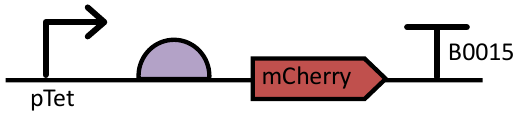
Figure 26: Examples of labels on